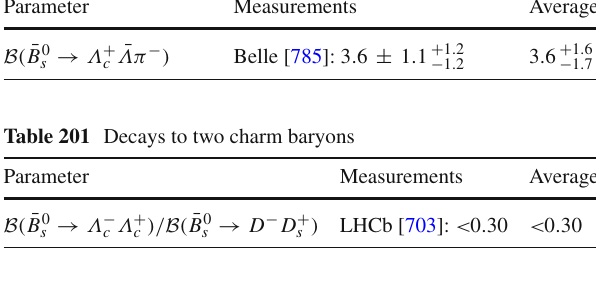
Table 200 Decays to one charm baryon [ 10 − 4 ] Parameter